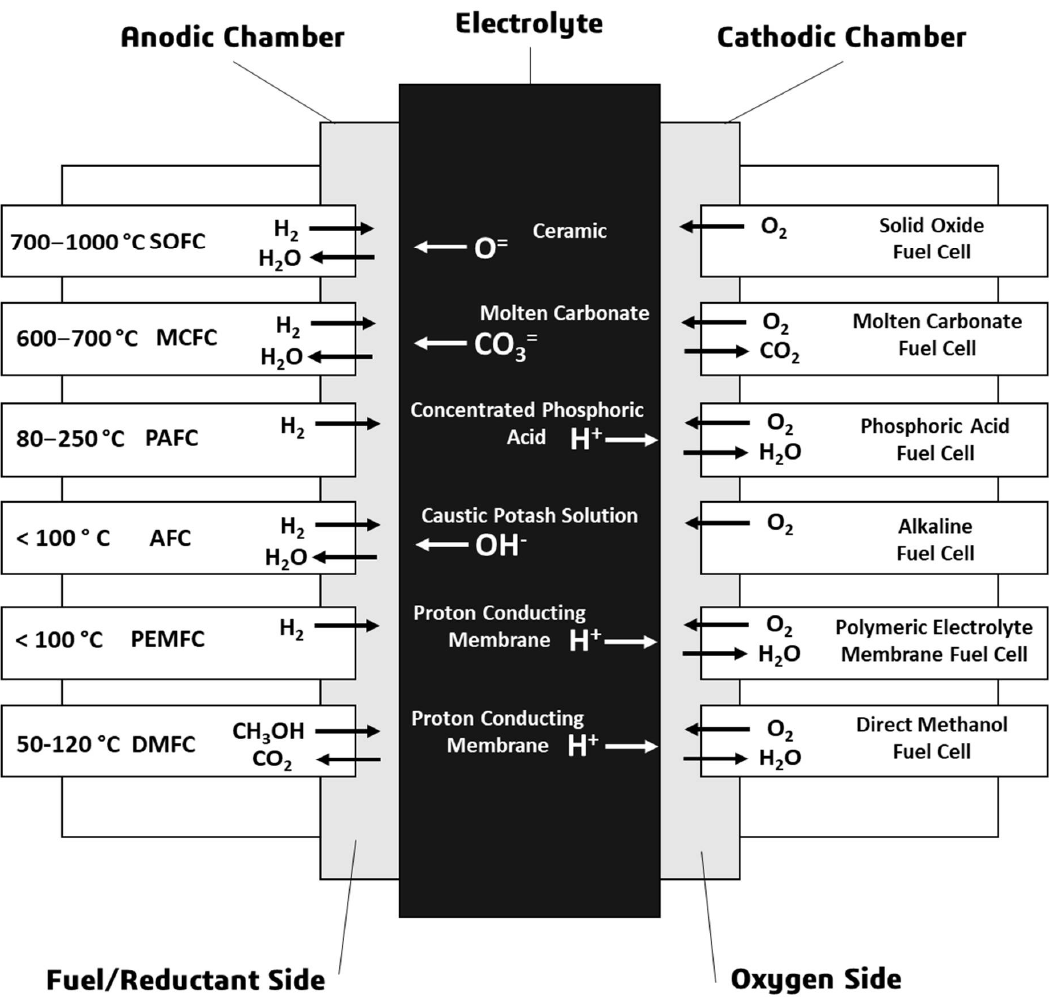
Figure 1. Fuel cell technology overview.